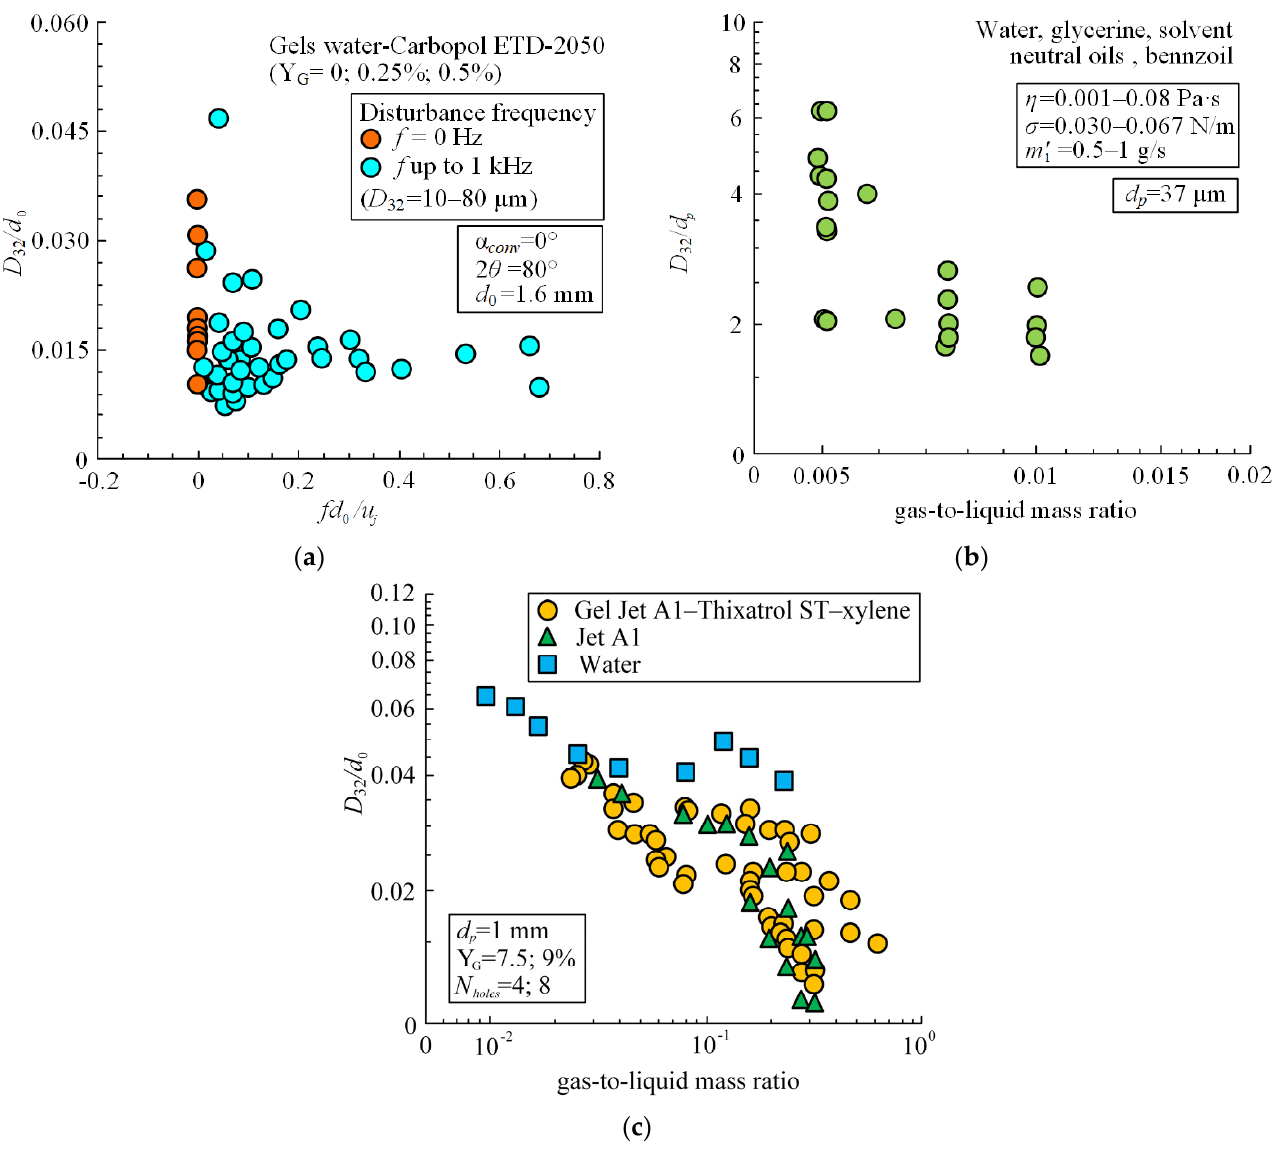
Figure 16. Dimensionless Sauter mean diameters of droplets. Designs of spraying devices: ( a ) Two-jet spraying followed by collision of the jets with the teeth of a pair of wheels and three-jet spraying with pulsating flows [97]; ( b ) “Flash-boiling atomizer” with a porous insert (pore diameter d p ) at the nozzle outlet [166,176]; ( c ) Atomizer with internal impact on flow [81,95,179].